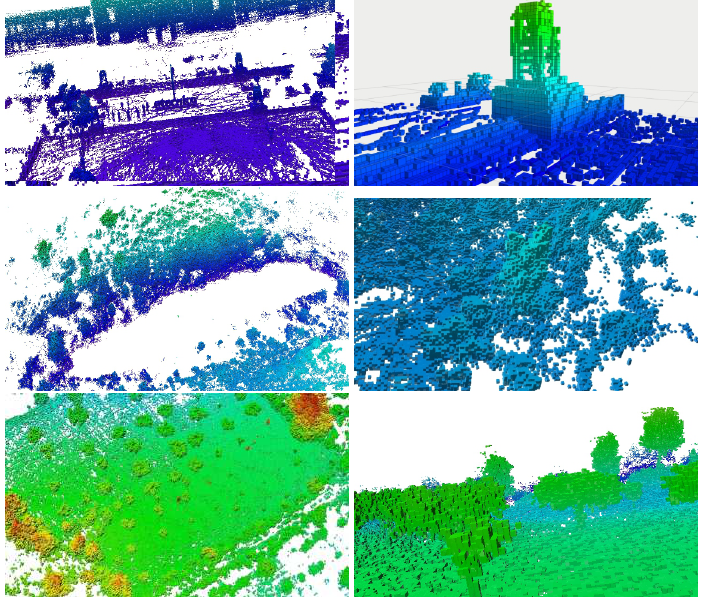
Figure 21. Octomaps with occupied areas from the three scenarios A ( top ), B ( middle ) and C ( bottom ). Left column presents a broad view, and the right column a detailed